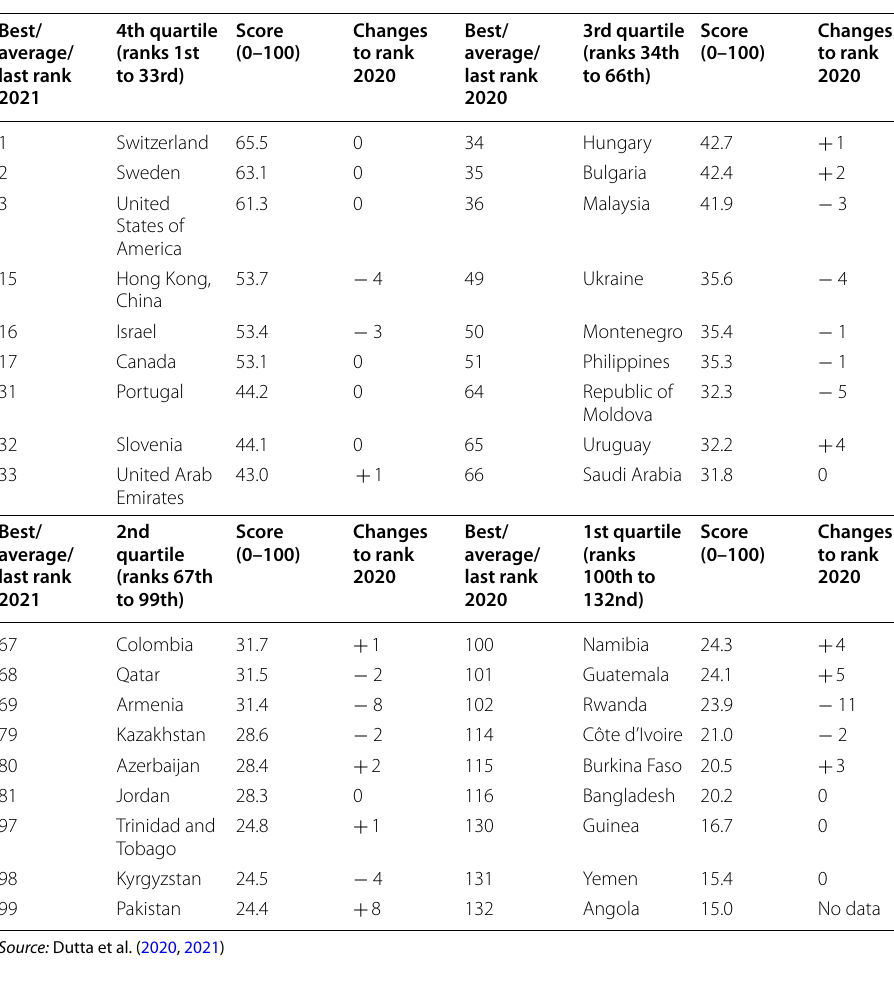
Table 1 The innovative potential of business practice in the general context of the economy: